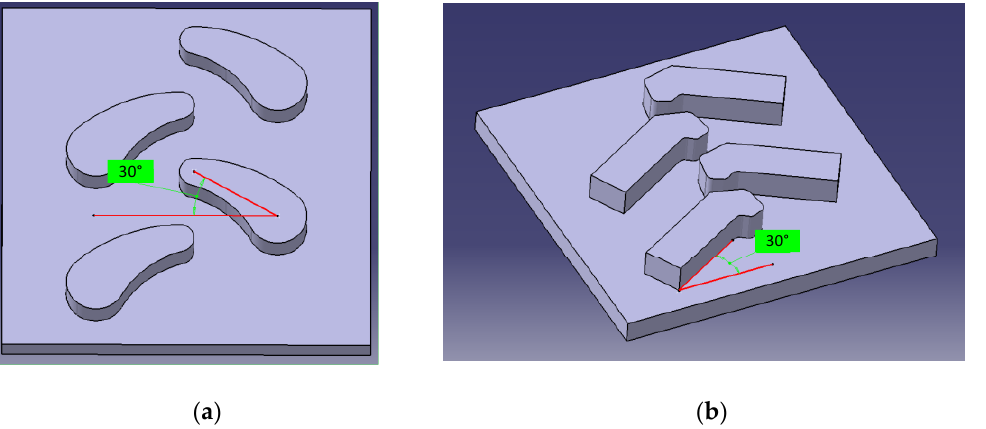
Figure 4. Tire block 3D-model: ( a ) biomimetic tire-block-model; ( b ) Common tire-block-model.0.